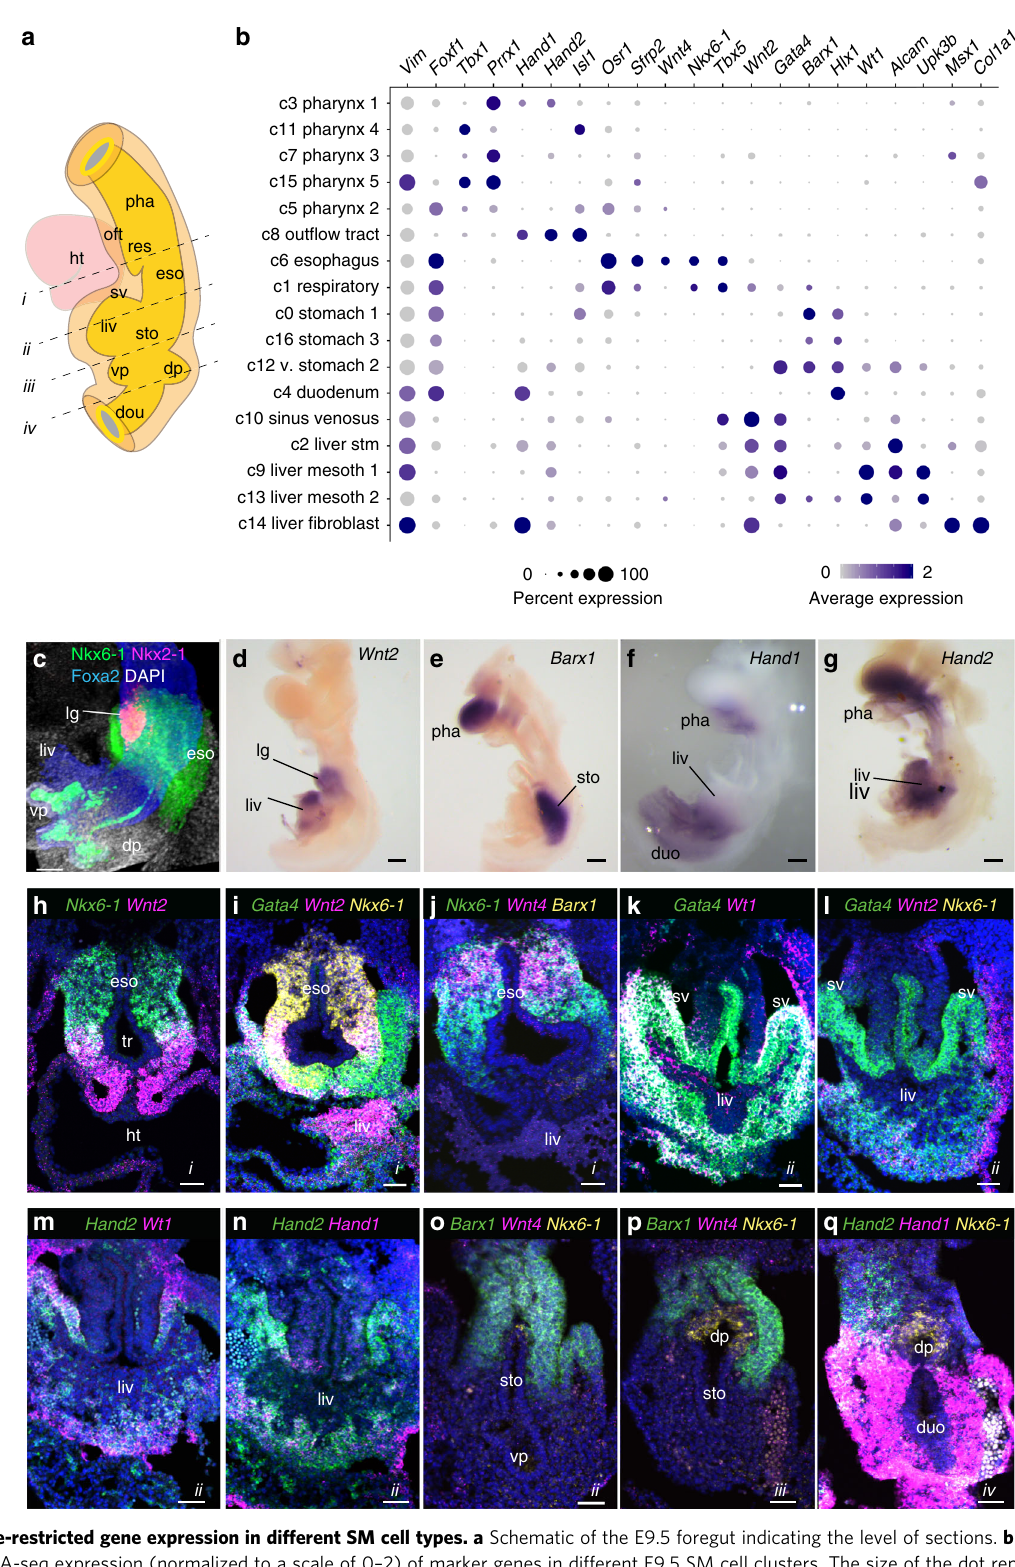
Fig. 2 Lineage-restricted gene expression in different SM cell types. a Schematic of the E9.5 foregut indicating the level of sections. b Dotplot showing average scRNA-seq expression (normalized to a scale of 0 – 2) of marker genes in different E9.5 SM cell clusters. The size of the dot represents the % of cells in a cluster expressing the marker. c – g Whole-mount immunostaining ( c ) or in situ hybridization ( d – g ) of dissected E9.5 foregut tissue. n =